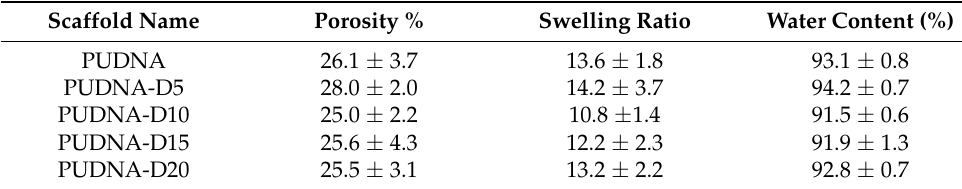
Table 1. Effect of polysaccharide formulation on hydrogel properties: porosity %, swelling ratio, and water content. Results are expressed as mean values ±